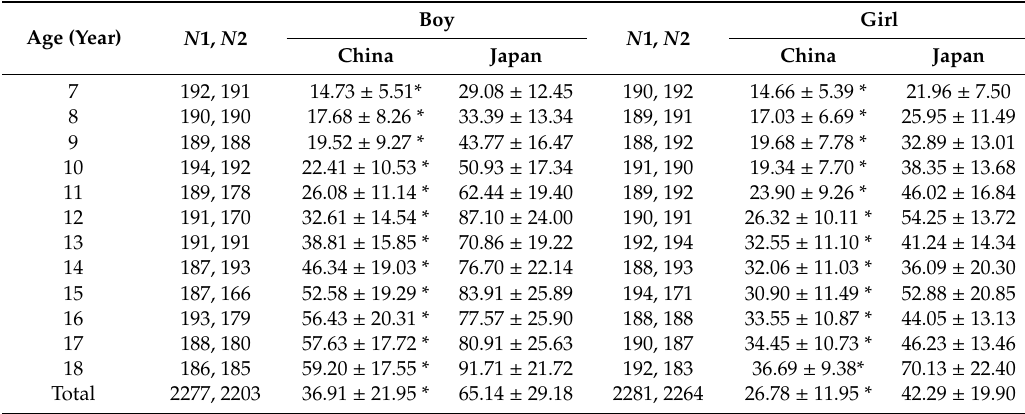
Table 2. Di ff erences in 20 m shuttle run test (20mSRT) performance between Chinese and Japanese children and adolescents